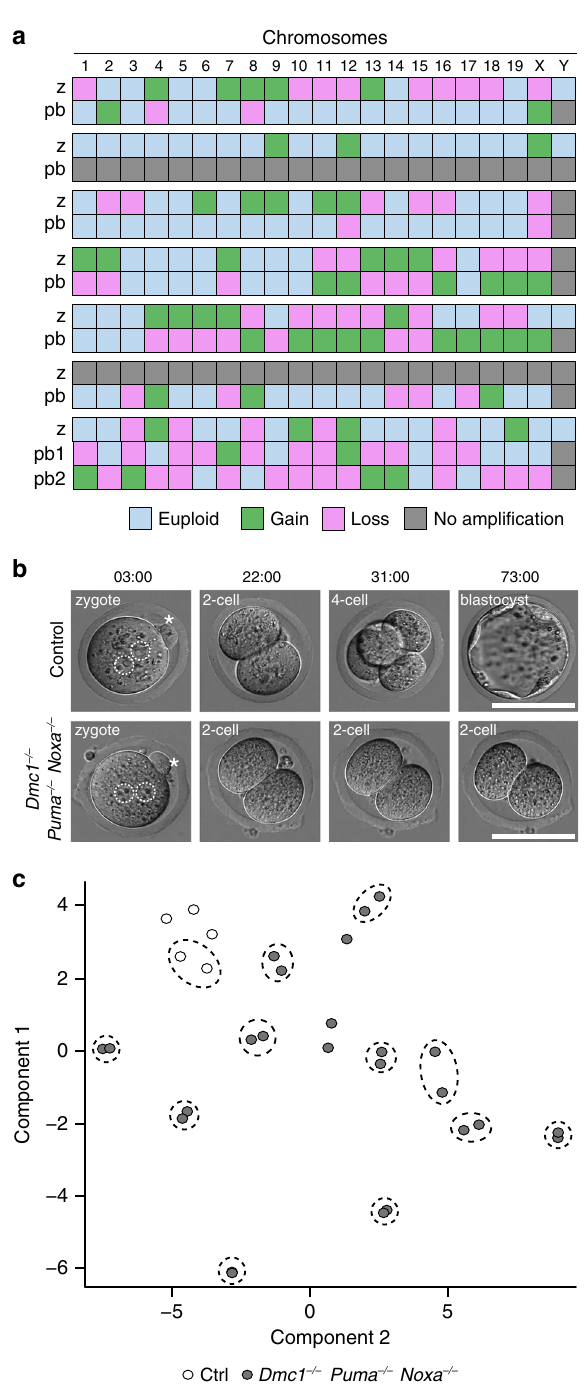
Fig. 4 Dmc1 − / − Puma − / − Noxa − / − females generate embryos. a Heatmap showing chromosome gains and losses in Dmc1 − / − Puma − / − Noxa − / − zygotes and their matched polar body, showing multiple reciprocal chromosomal aneuploidies. b Development of embryos from control ( n = 3 females, n = 48 zygotes, N = 2 experimental repetitions) and Dmc1 − / − Puma − / − Noxa − / − females ( n = 3 females, n = 37 zygotes, N = 2 experimental repetitions). Dotted circles outline paternal and maternal pro- nuclei. Asterisks indicate second polar body. Time shows hours from zygote collection. Scale bar 100 µ M. c t -SNE plot of single-cell RNA-seq analysis of control and Dmc1 − / − Puma − / − Noxa − / − blastomeres. Dotted circles represent pairs of blastomeres derived from the same embryo. Control (Ctrl) is Dmc1 + / − Puma + / − Noxa + / −